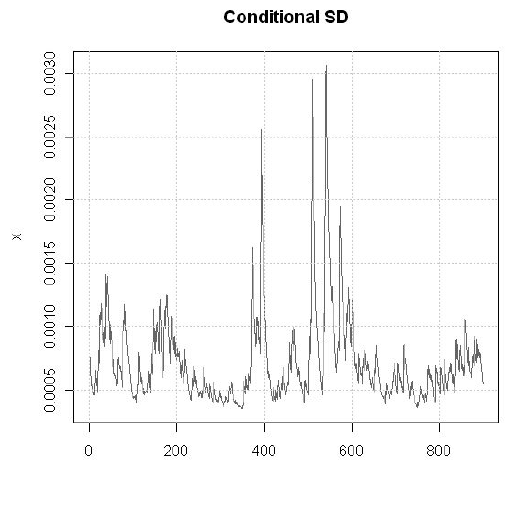
Fig. 2. The estimated volatility for ARMA(5,0) + GARCH(1,1) process - model (6).